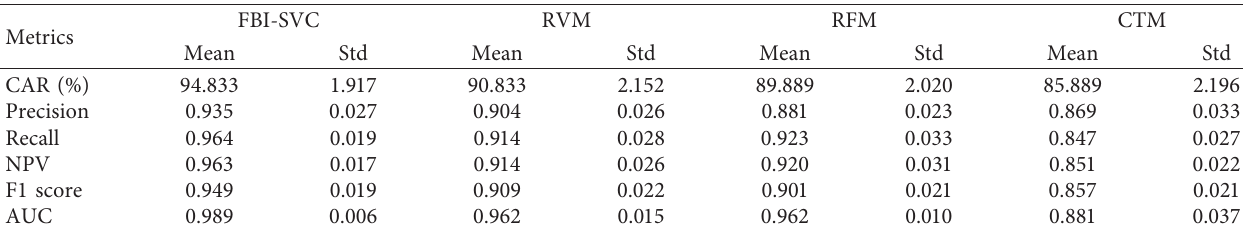
Figure 8: The FBI-based optimization progress. Table 1: Experimental result